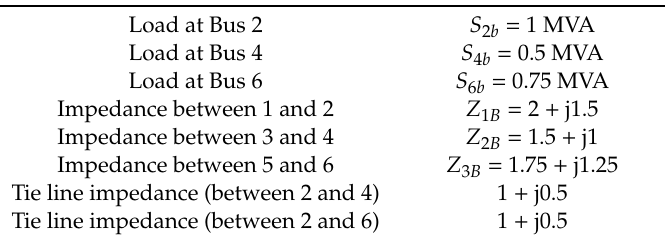
Table A1. Parameters of simple test distribution system.